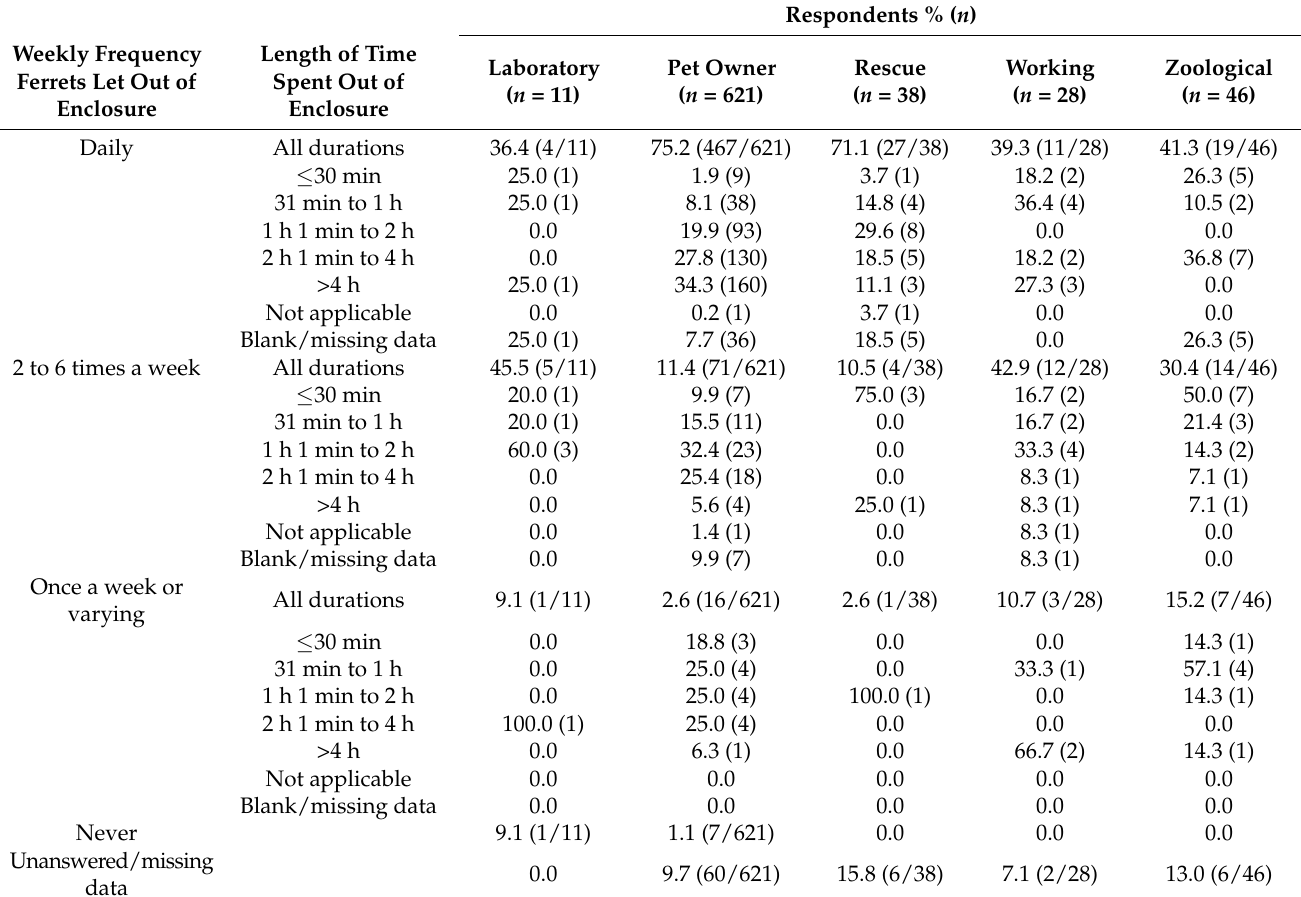
Table 2. Out-of-house exploration opportunities provided to ferrets by caretaker